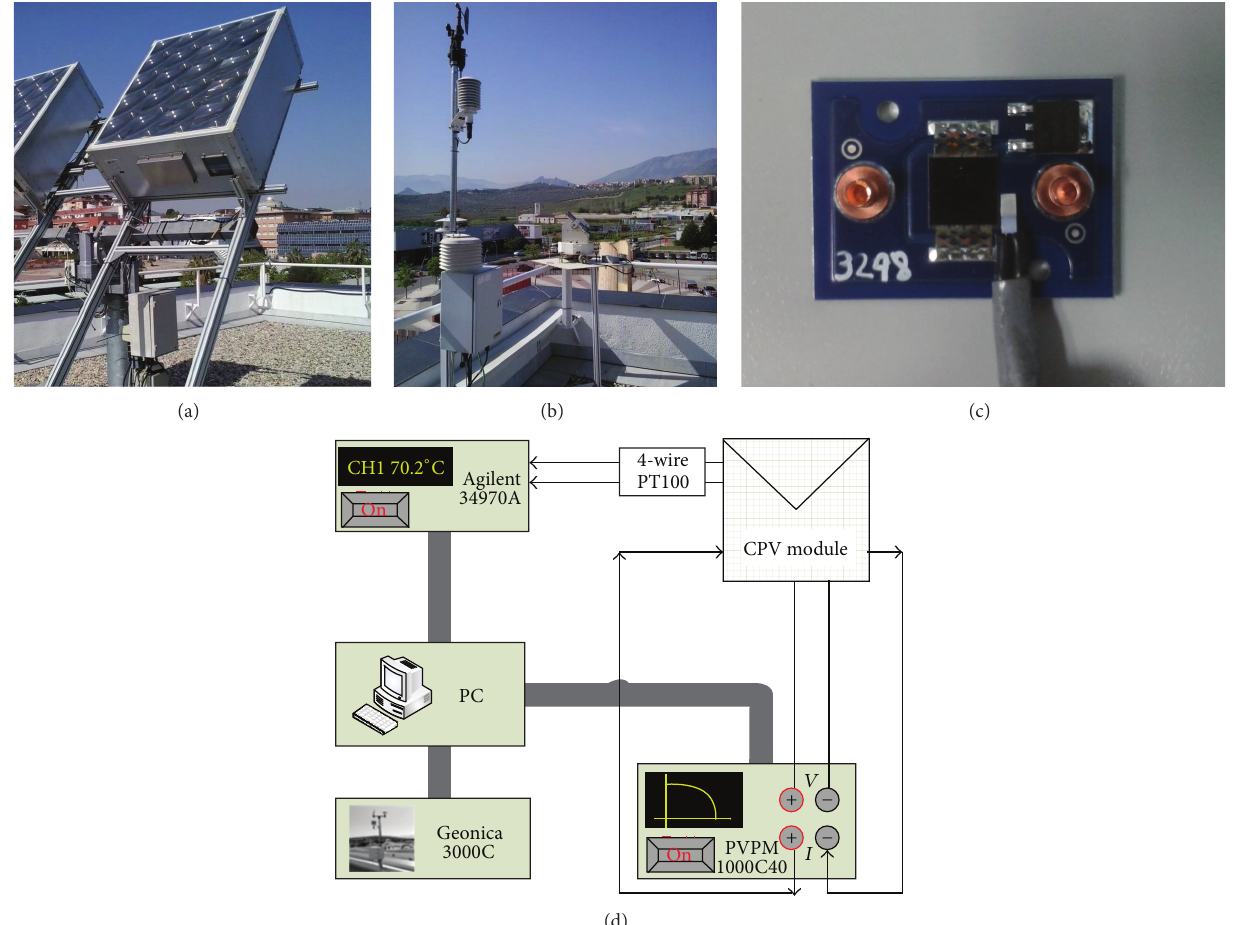
Figure 3: Experimental set-up used to carry out the study at the Centre of Advanced Studies in Energy and Environment of the University of Jaen.